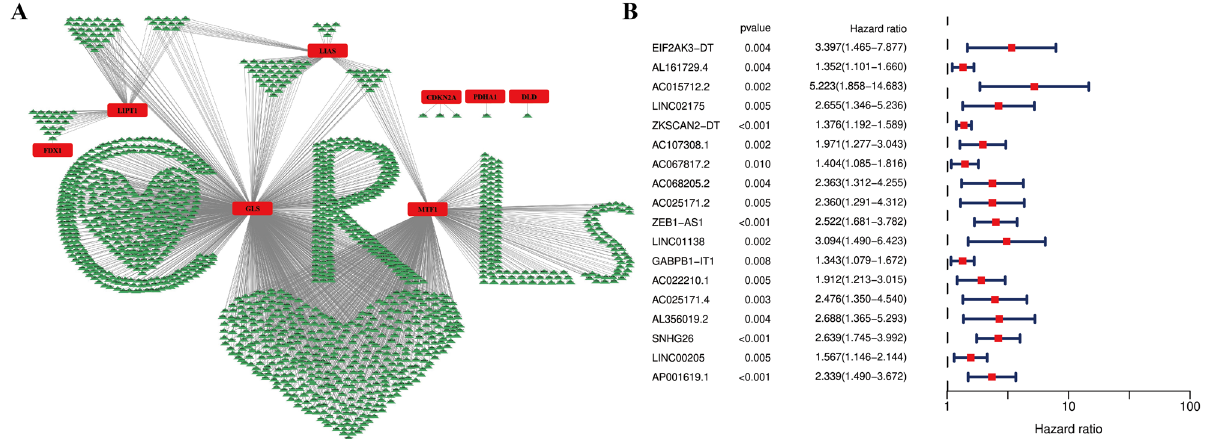
Figure 3. Co-expression network and prognostic cuproptosis-related lncRNAs (CRLs). ( A ) The co-expression network between cuproptosis-related genes and prognostic lncRNAs. ( B ) The forest plot of univariate Cox regression analysis for prognostic